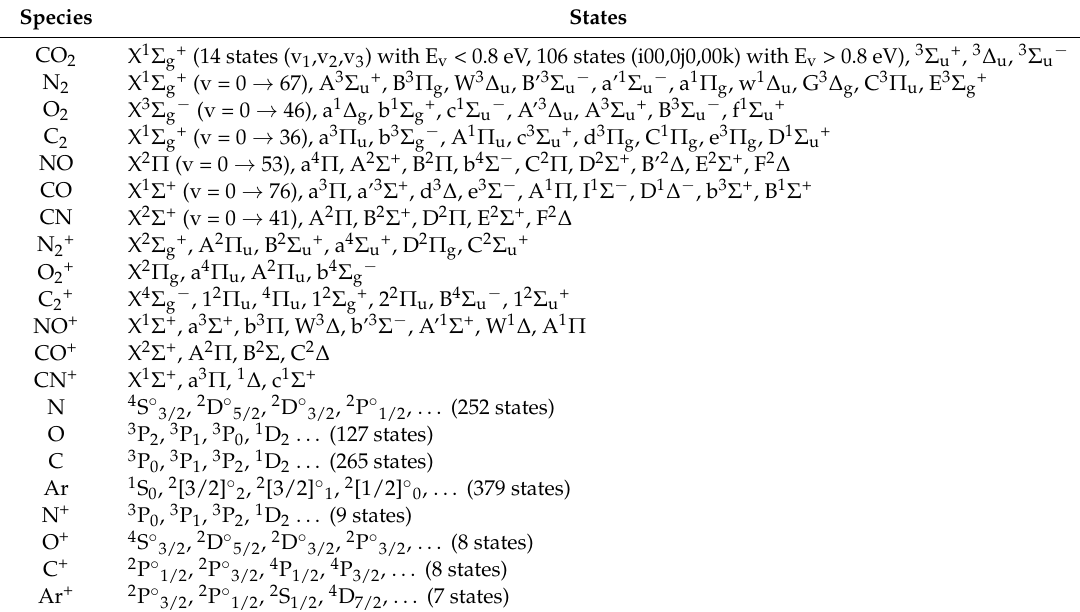
Table 1. List of the species and their excited states involved in CoRaM-MARS, the CR model developed at the CORIA laboratory for the CO 2 -N 2 -Ar mixtures.